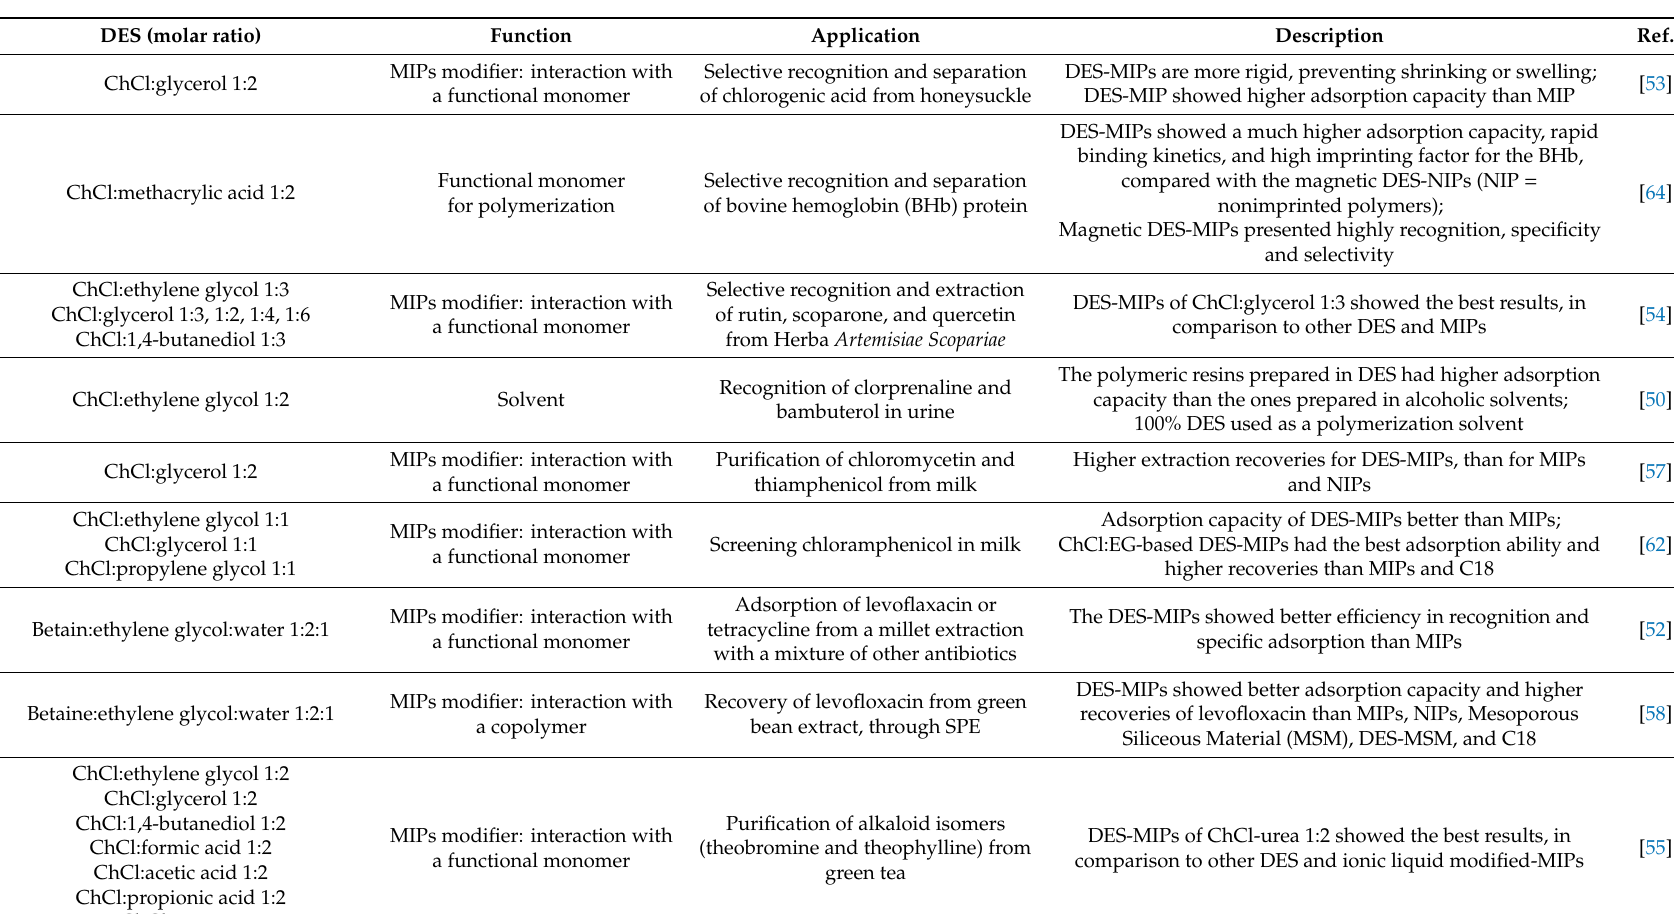
Table 2. Summary of the work reported in the literature regarding DES-molecular imprinted polymers (MIPs). DES (molar ratio) Function Application Description